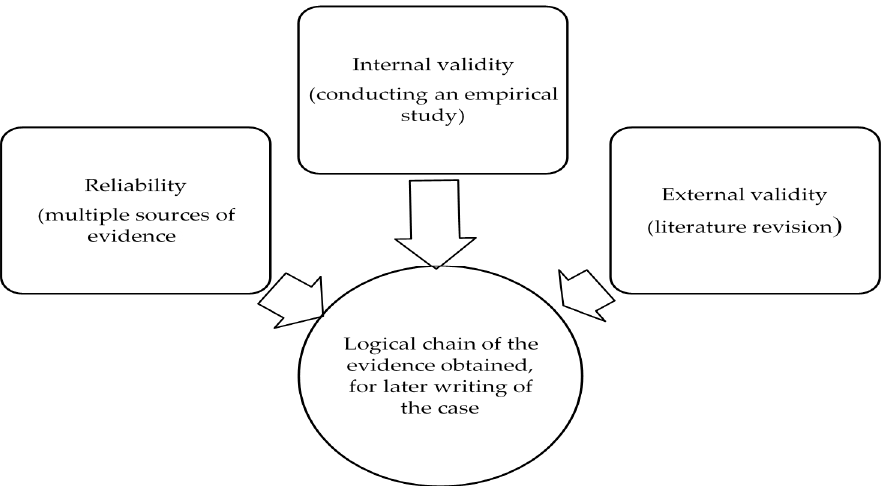
Figure 3. Principles adapted of Yin [77].